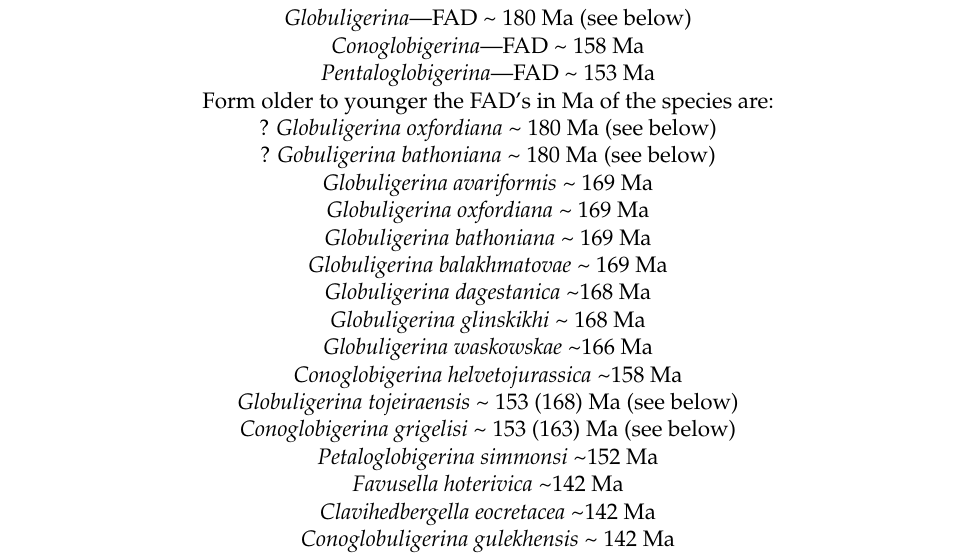
Table 1. Listing of the oldest age level and the level of first formal description of Jurassic planktonic